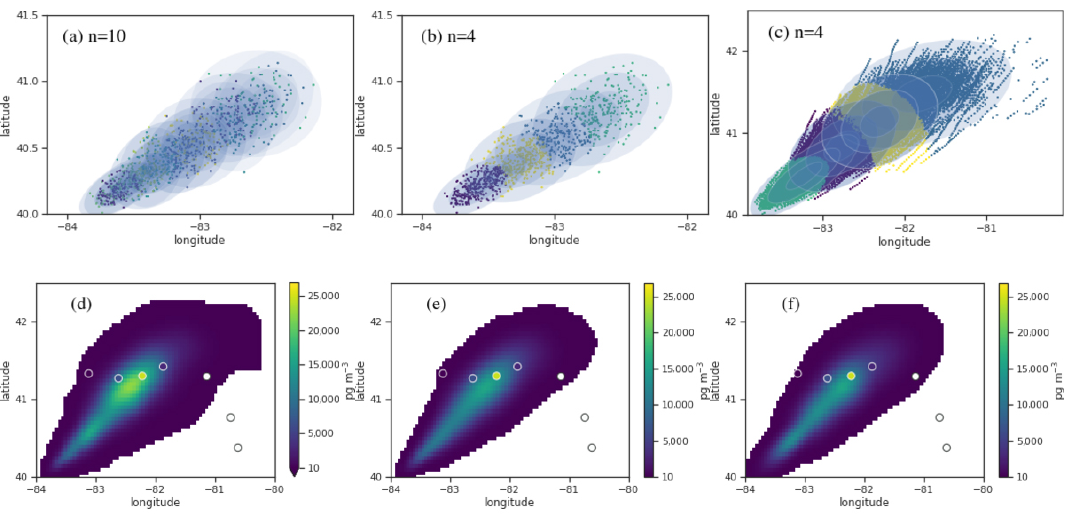
Figure 1. The top panels, ( a – c ) show particle positions at ( a , b ) 09/18/1983 21:00 UTC and ( c ) 09/18/1983 from 21 to 24 UTC with particle positions output every 5 min. The Gaussian fits are shown in light blue and the colors of the particles indicate which cluster the particles were assigned to by the algorithm. The bottom panels, ( d – f ) show 3 h averaged concentrations calculated from the fits on a 0.05 ◦ × 0.05 ◦ 25 m grid from the ground to 25 m. A threshold of 1 pg m 3 has been applied and station measurements for the CAPTEX1 experiment are shown by the circles. ( d , e ) were calculated from separate fits to each time period and the panels above show the first such fit. ( f ) was calculated from one fit to all time periods which is shown in ( c